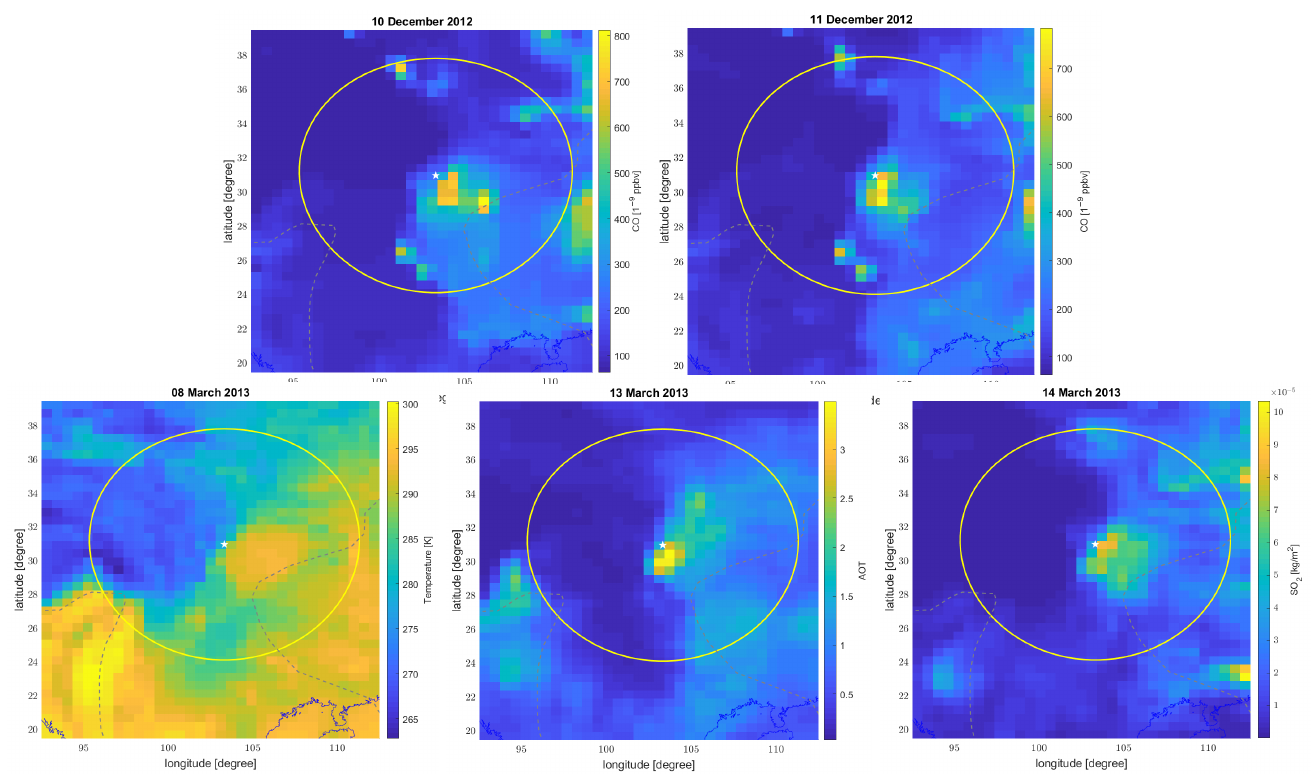
Figure 15. Maps of CO levels on 10 and 11 December 2012, Temperature on 8 March 2013, aerosol levels on 13 March 2013, and SO2 levels on 14 March 2013. The yellow circle represents the Dobrovosky radius of the Mw 6.7 Lushan 2013 earthquake. The white star indicates the epicenter of Mw 6.7 Lushan 2013 earthquake.